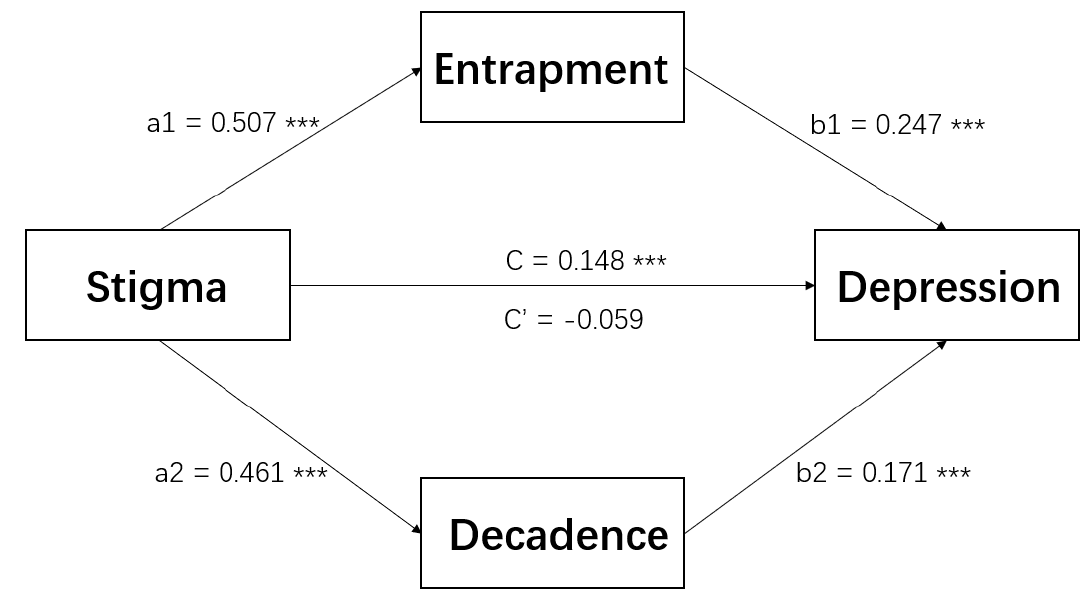
Figure 2. The mediating role of entrapment and decadence in the relationship between stigma and depression ( n = 1283). *** p < 0.001. Note: education level and doses of vaccine significantly associated with depression in logistic regression were controlled as covariates in the path analysis. C’: change in coefficient when mediating variables are